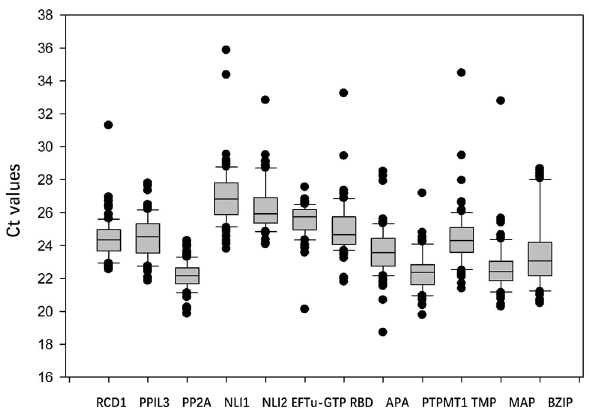
Figure 2. qRT-PCR Ct values of 12 candidate reference genes across all samples. The box graph indicates the 25th and 75th percentiles. The line across the box depicts the median. The lower and upper dashes represent the minimum and maximum values,